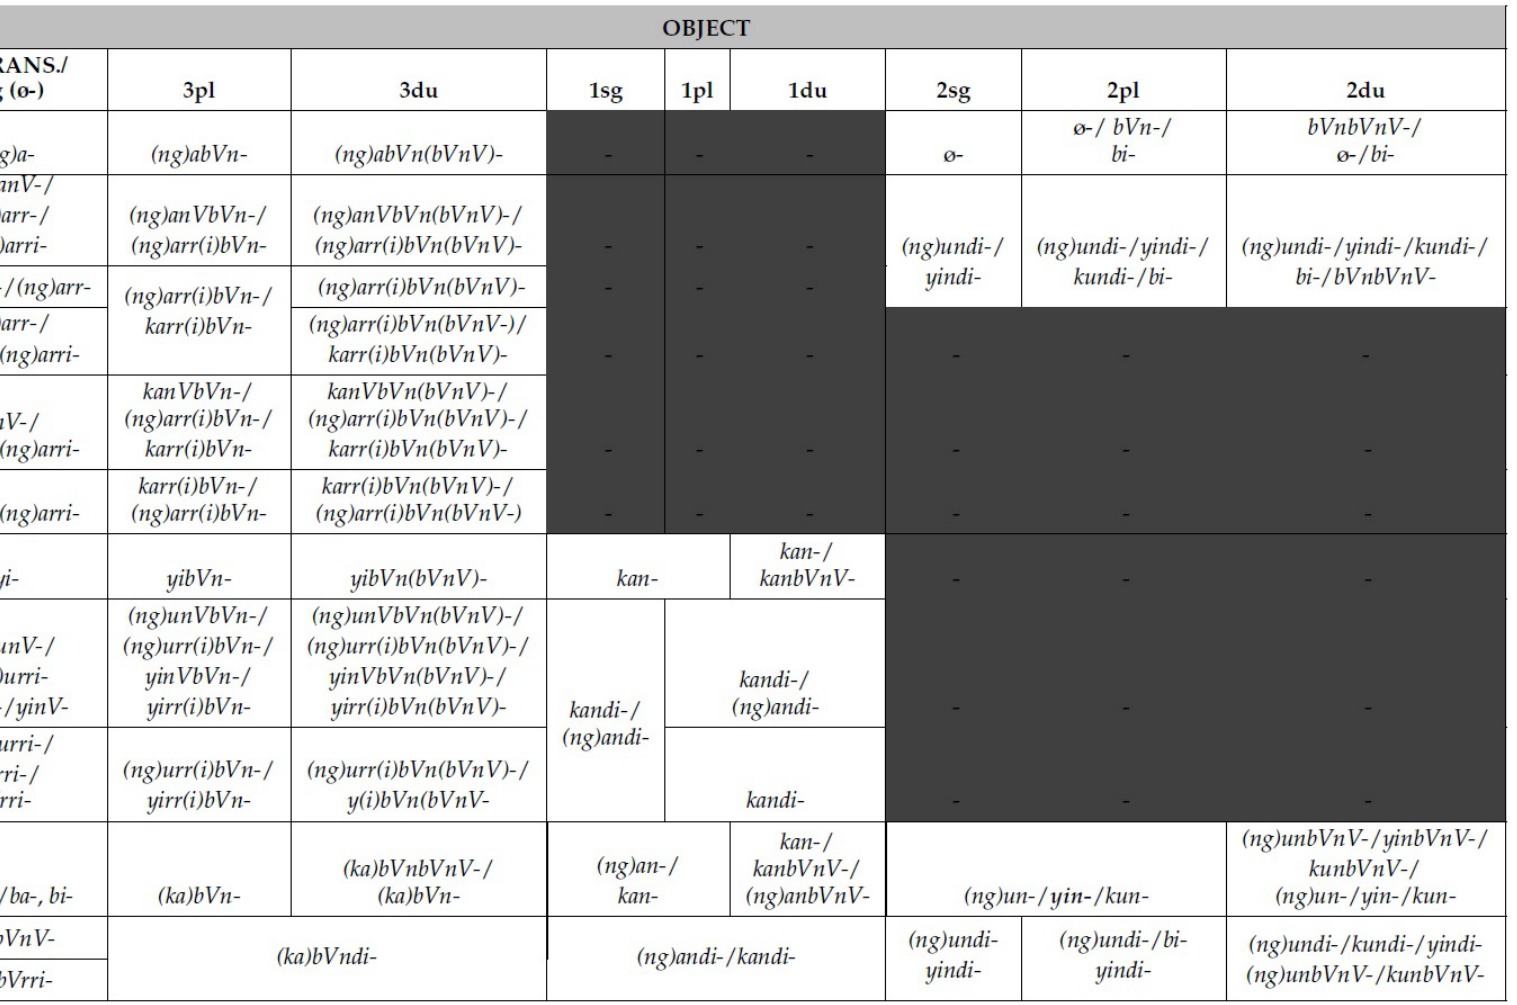
Table 11. All attested pronominal prefix